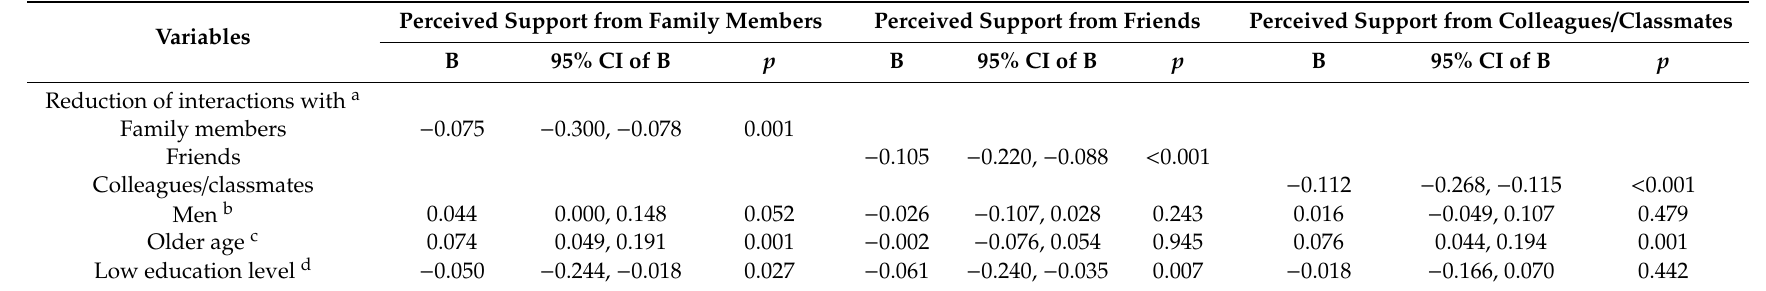
Table 2. Association between the Reduction of Social Interaction and Perceived Social Support: Multiple Regression Analysis.